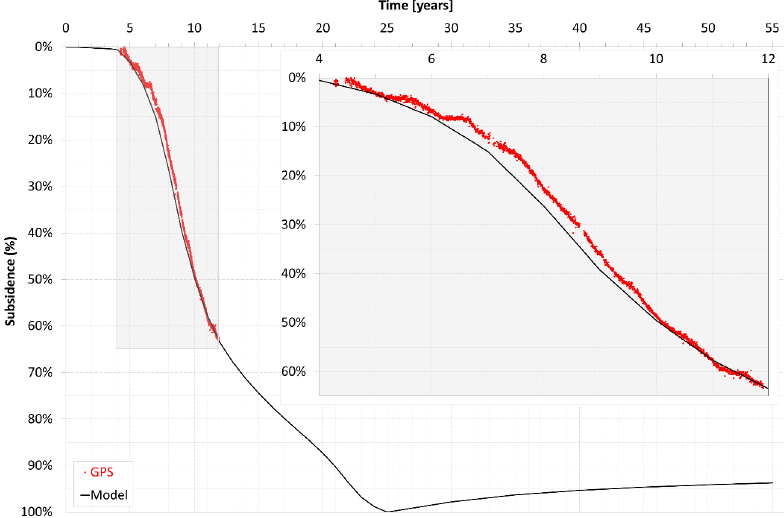
Figure 2. Time evolution of subsidence at platform B: GPS data versus model estimate, with